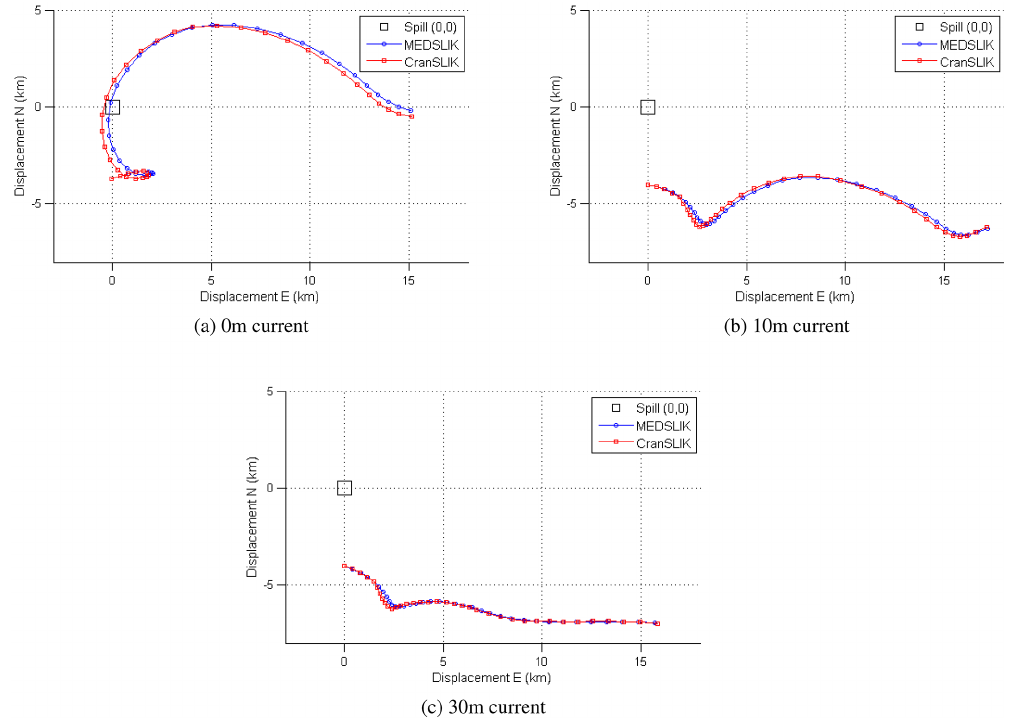
Figure 3. Centre of mass trajectory forecasts (hours 1–36) for the Algeria contour case using the current at different depths as the advective